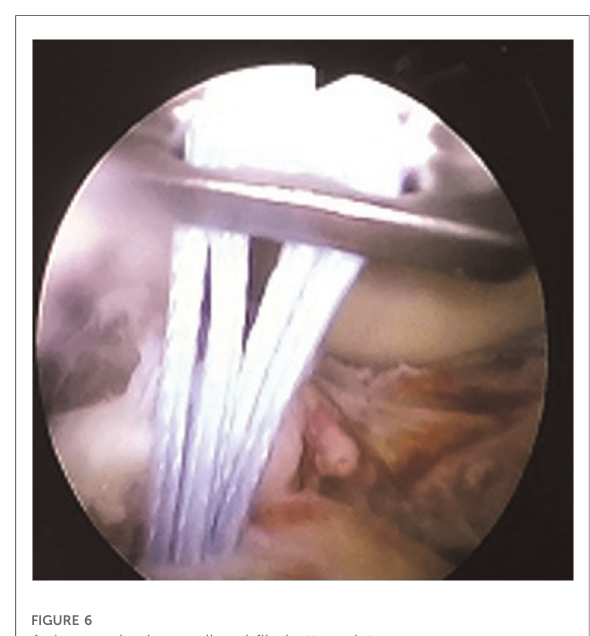
FIGURE 6 Arthroscopic view: pull and fl ip button